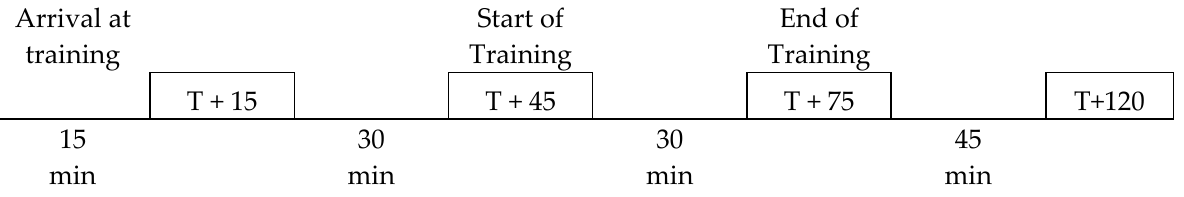
Figure 1. An overview of the different sample moments of this study relative to the arrival of the dogs at the training ground.